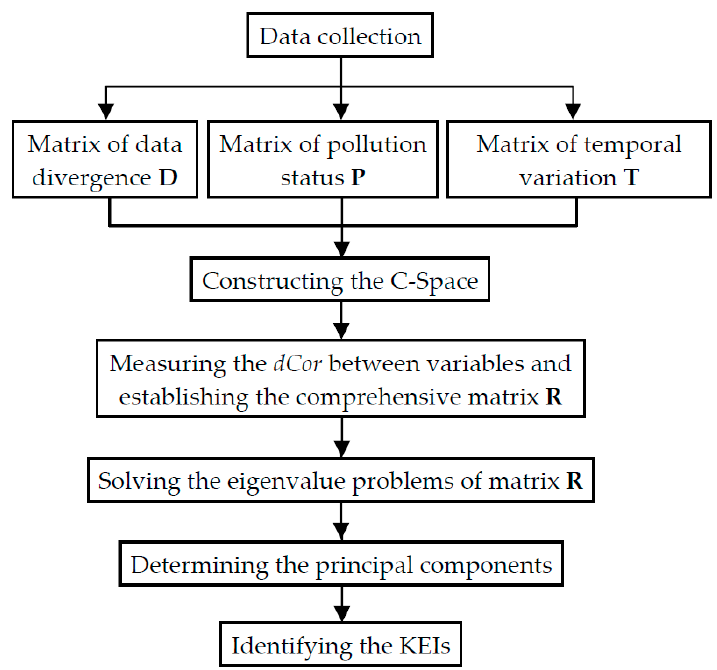
Figure 2. Flow-chart of the main steps used to perform the modified principal component analysis approach (MPCA).